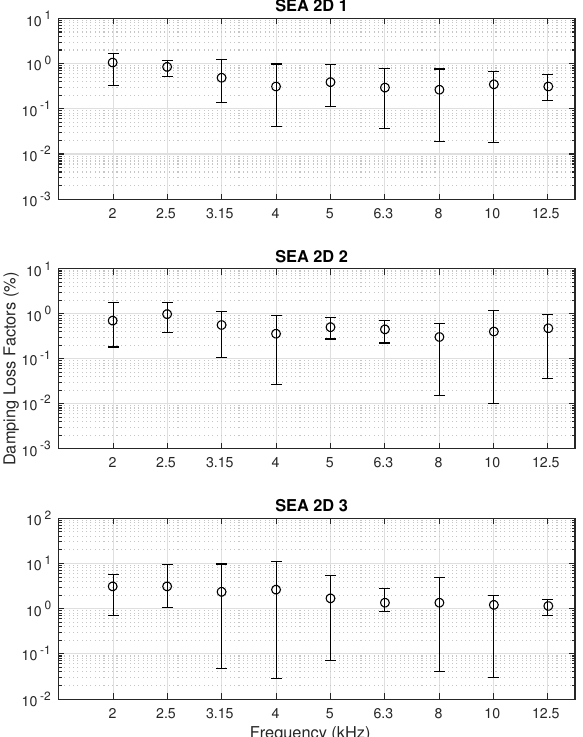
Figure 17. Damping loss factors obtained experimentally for each SEA subsystem.